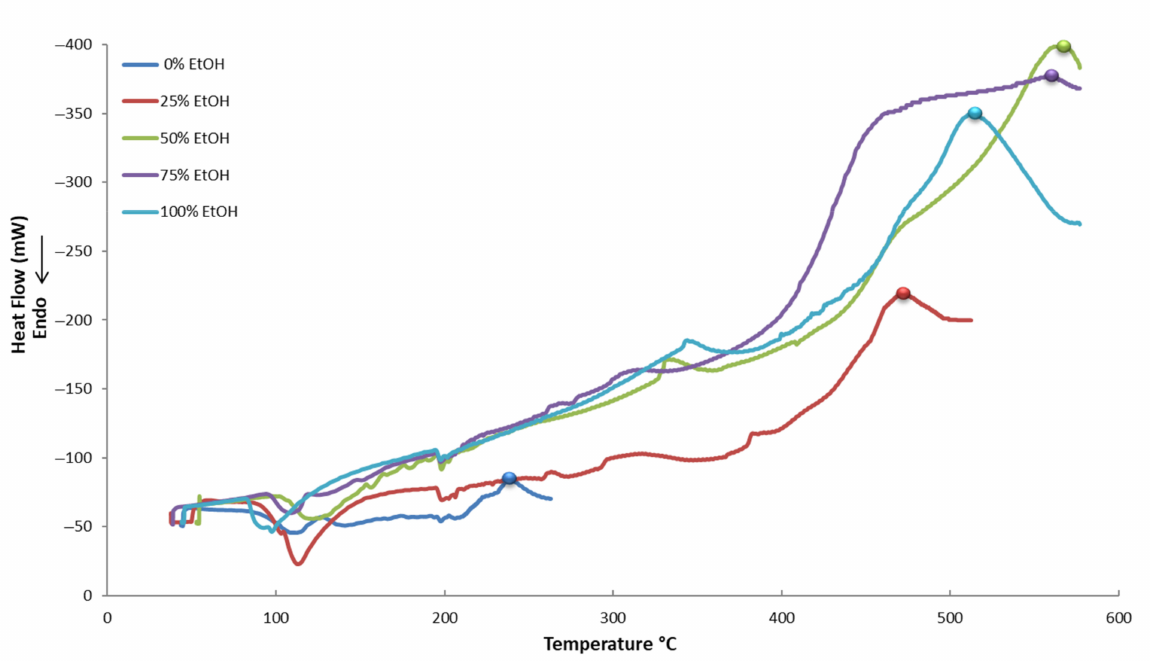
Figure 6. Differential scanning calorimetry (DSC) thermograms of PEF-treated (10 µ s) samples in five different tested